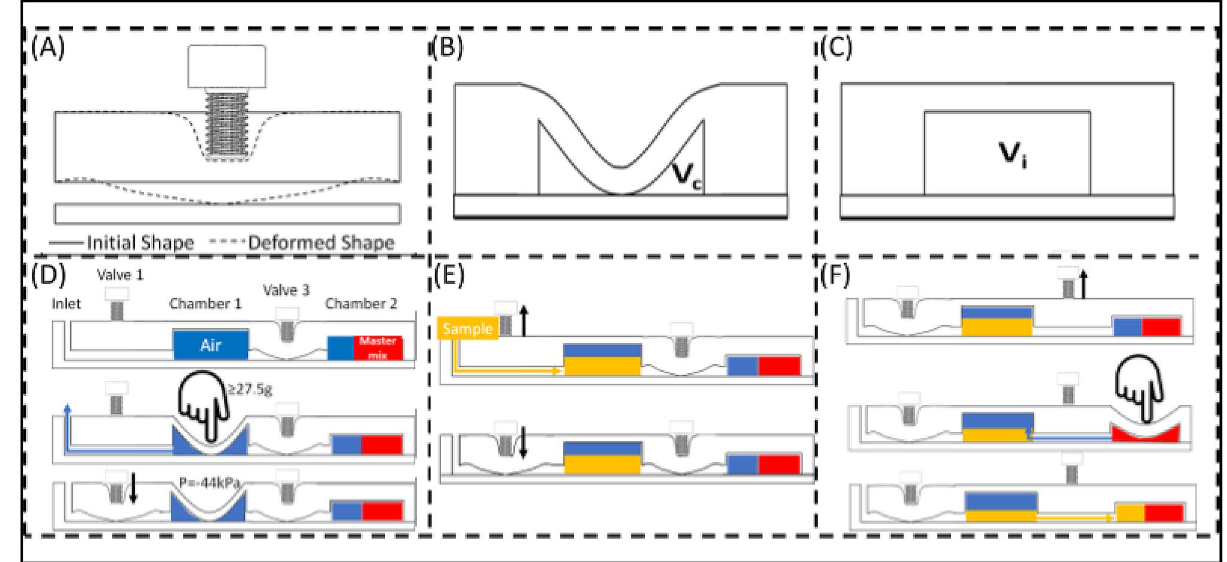
Figure 5. Pumping and Valving mechanism. ( A ) Schematic for the valve mechanism. ( B ) Drawing of a compressed chamber, and ( C ) an uncompressed chamber. ( D ) Process for generating vacuum in Chamber 1. ( E ) Process for loading Chamber 1. ( E ) Process for loading Chamber